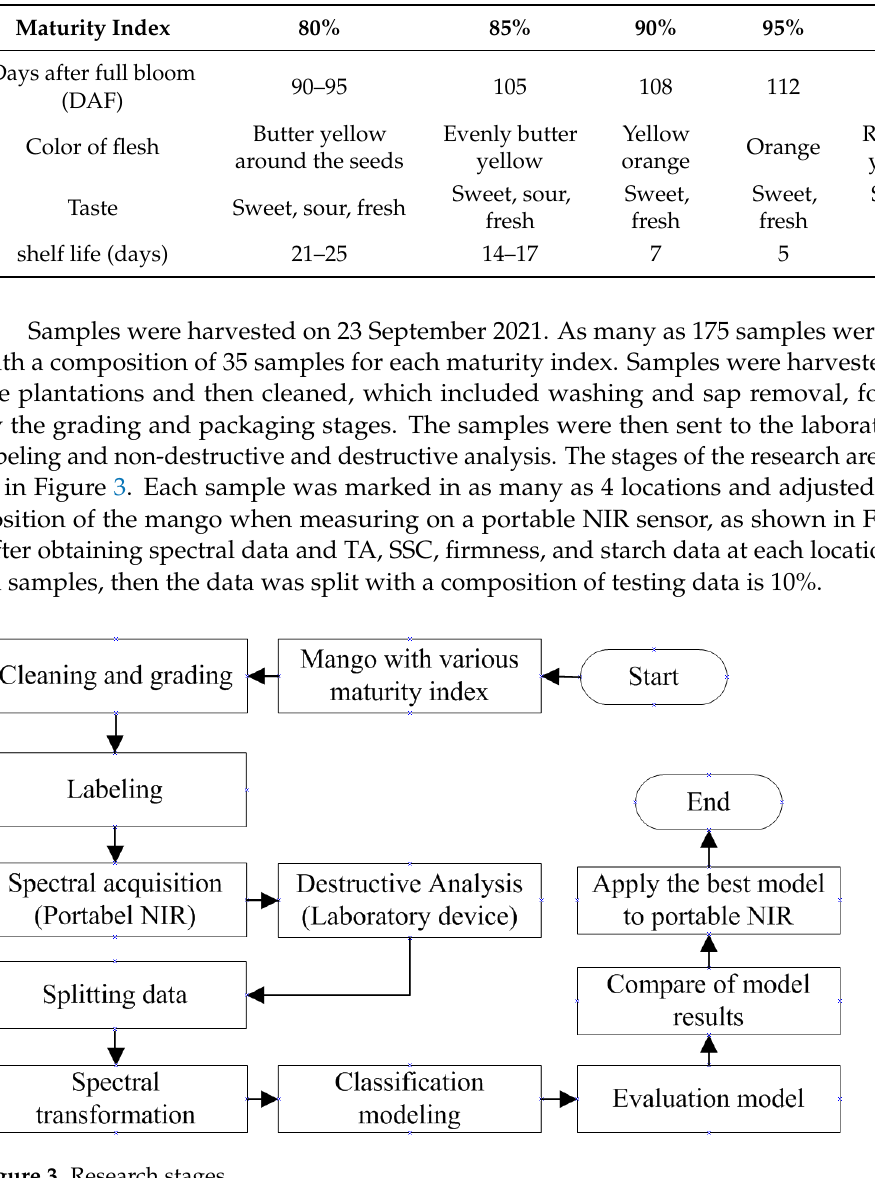
Figure 3. Research